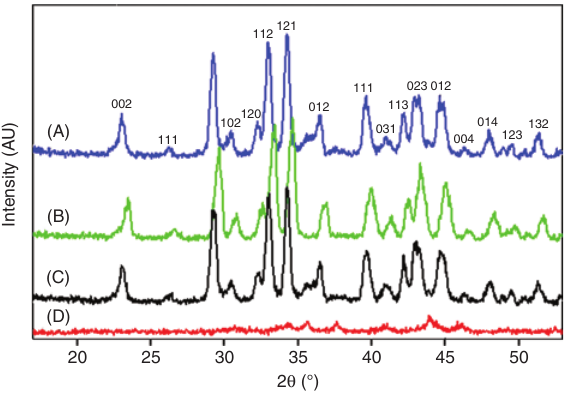
Se nanoparticles 2